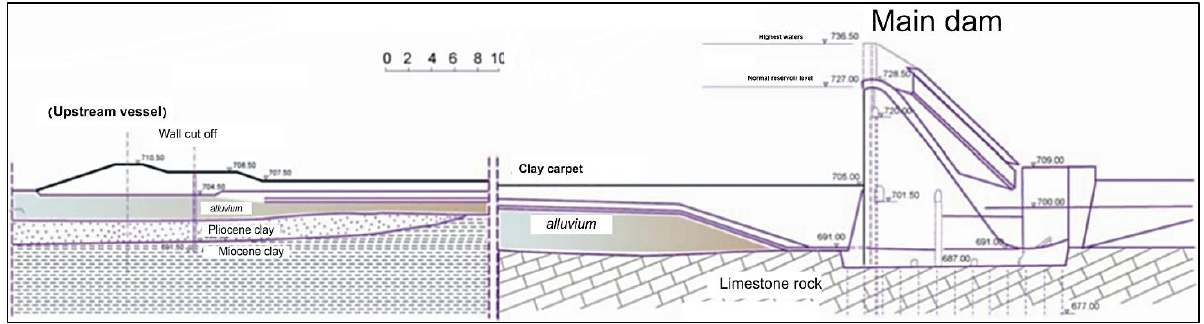
Figure 3. Cross section, along the valley, of Hammam-Grouz dam, Algeria